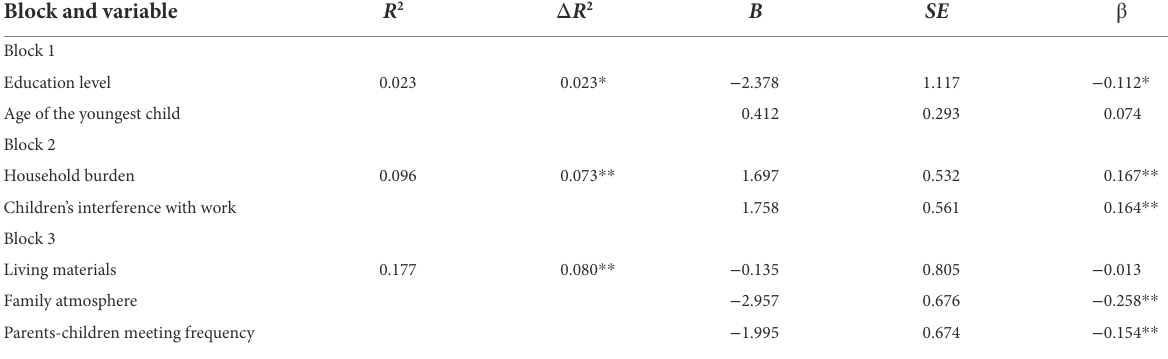
TABLE 3 Linear regression analysis: Best model to predict parental